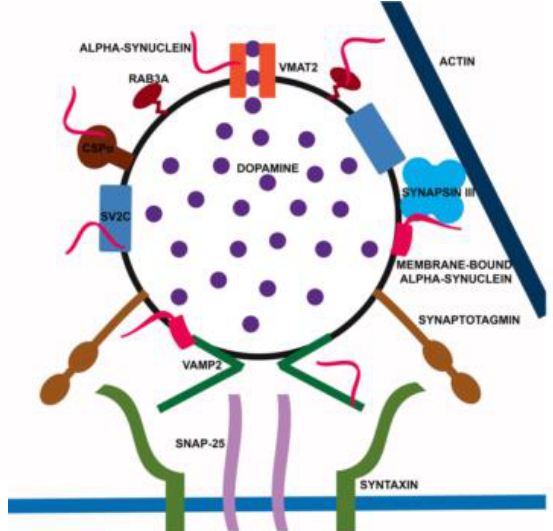
Figure 3. Overview of the α -syn interactome at SV. Alpha-synuclein interacts with multiple SV proteins as well as with SV membranes. By orchestrating its SV partners, α -syn contributes to neurotransmitter filling, SV tethering, docking and fusion. Please note that syn III is the abbreviation for synapsin III.